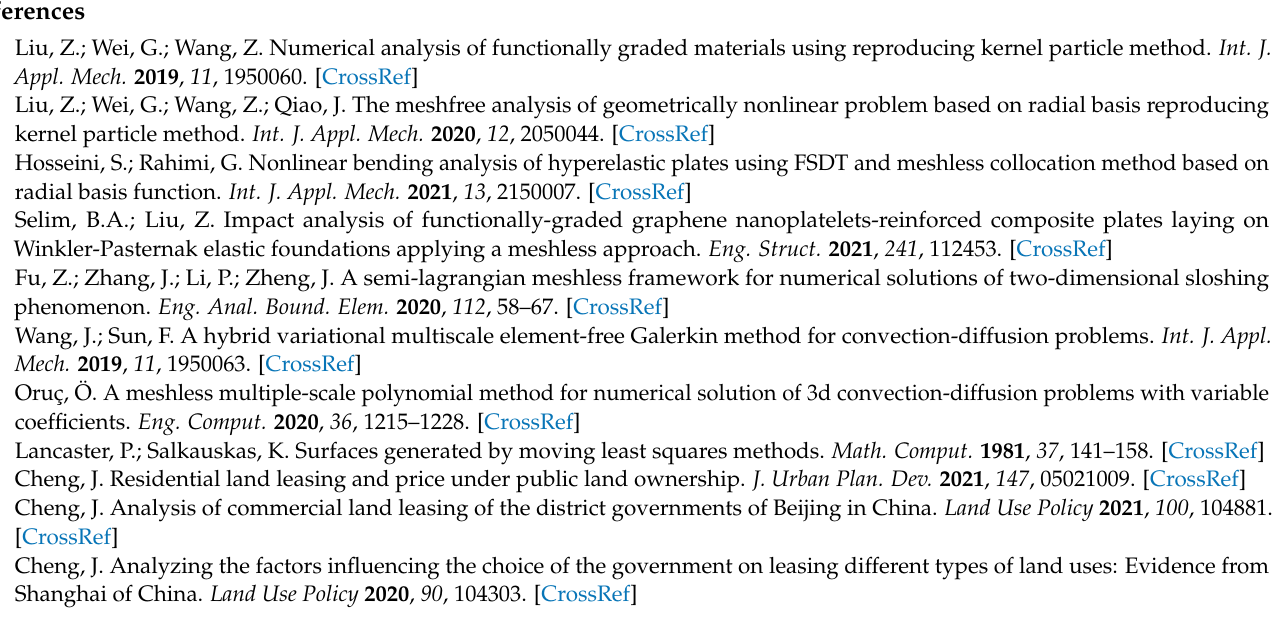
(cid:12) (cid:12)(cid:12) (cid:12) (cid:12)(cid:12) (cid:12) (cid:12) (cid:12) (cid:12) − u h (cid:12) u (cid:12) of the Ref. [58], EFG, VMEFG and DS-GIEFG methods for different